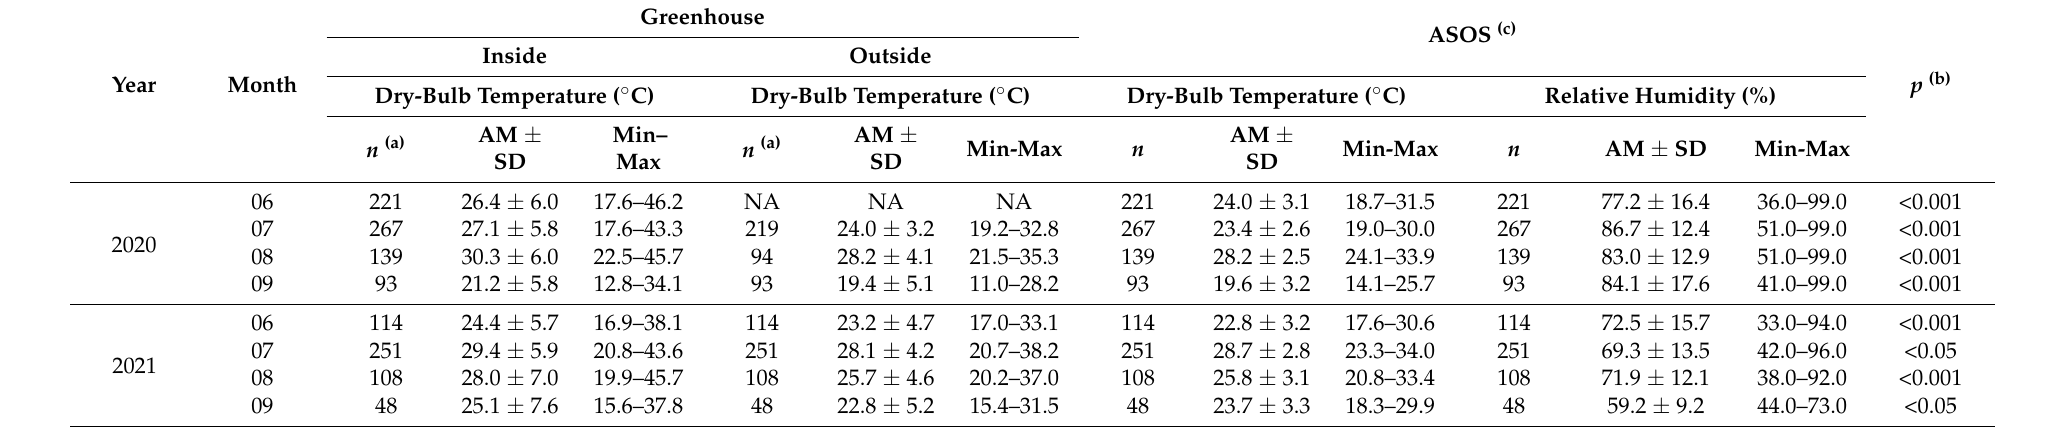
Table 2. Comparison of dry-bulb temperatures between greenhouse (inside and outside) measurements and ASOS